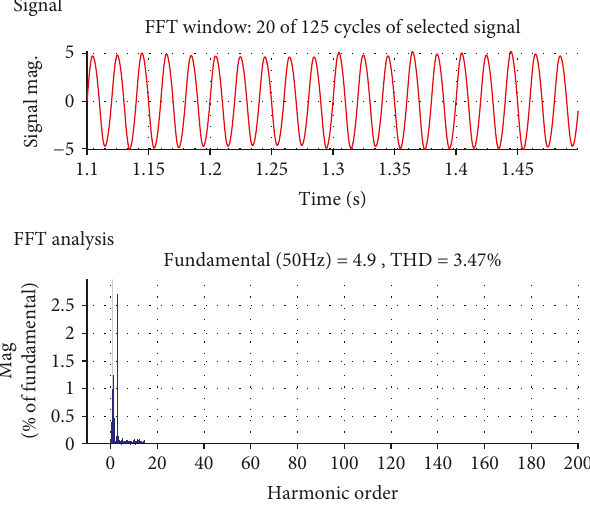
Figure 13: Harmonic distortion analysis of the controlled output